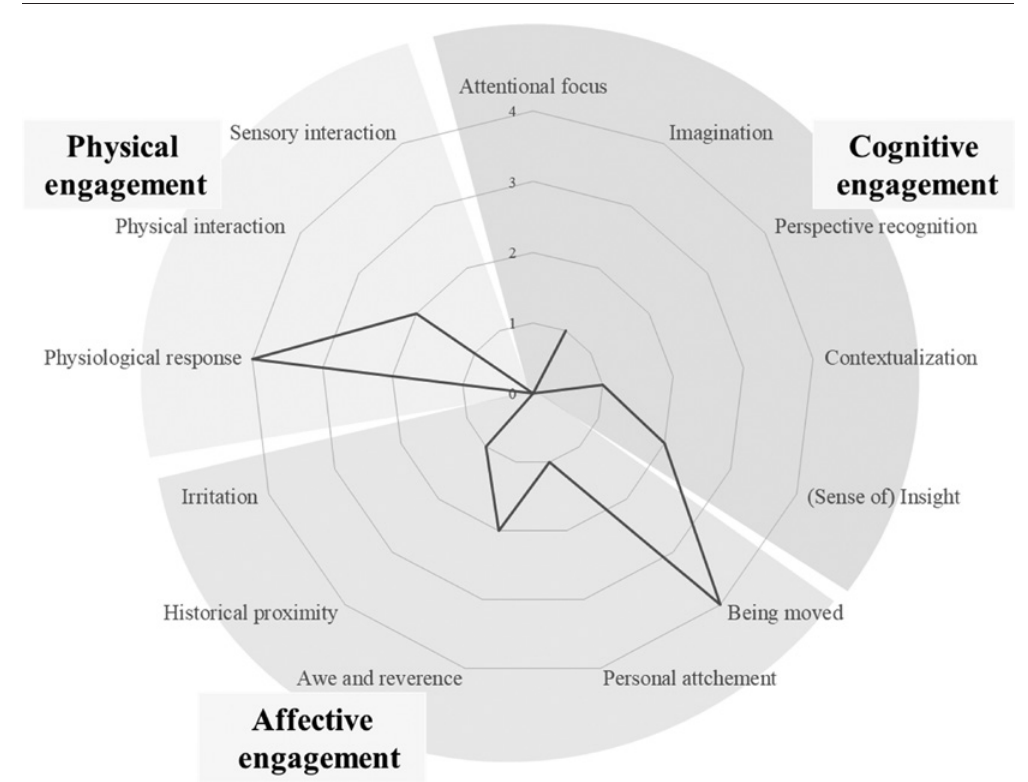
Figure 2: Hiroshima Museum example, showing the coding frequency for each